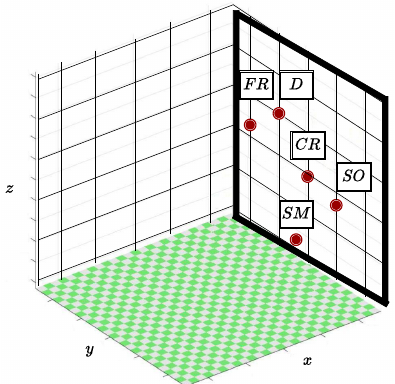
Figure 10. Plane with the referring regions to the textures.